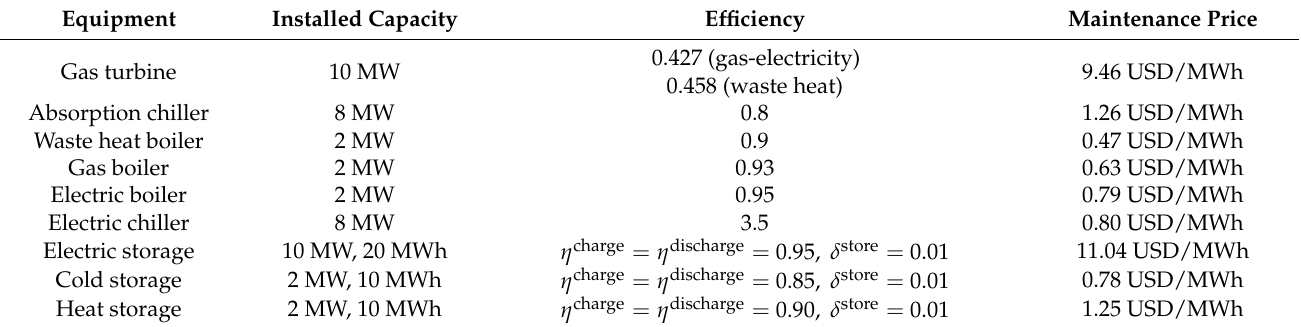
Figure 3. Load demand of an industrial park in a typical summer day. Table 1. Device parameters.